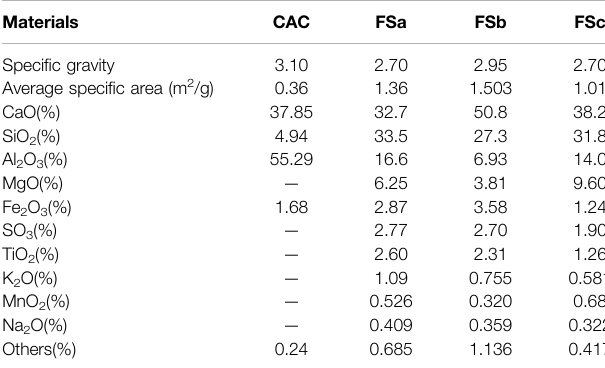
TABLE 1 | Chemical composition and percentage content of slag and